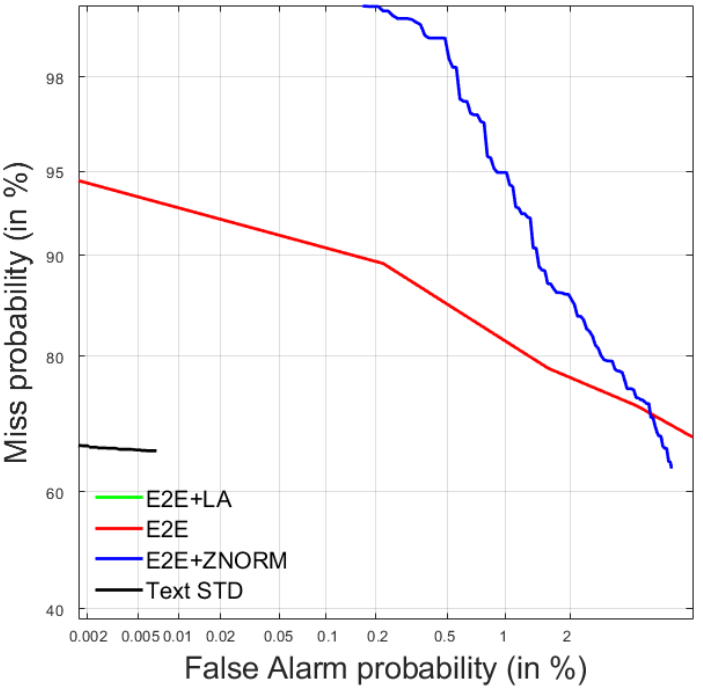
Figure 9. DET curves of the QbE STD systems and the text-based STD system for RTVE develop- ment